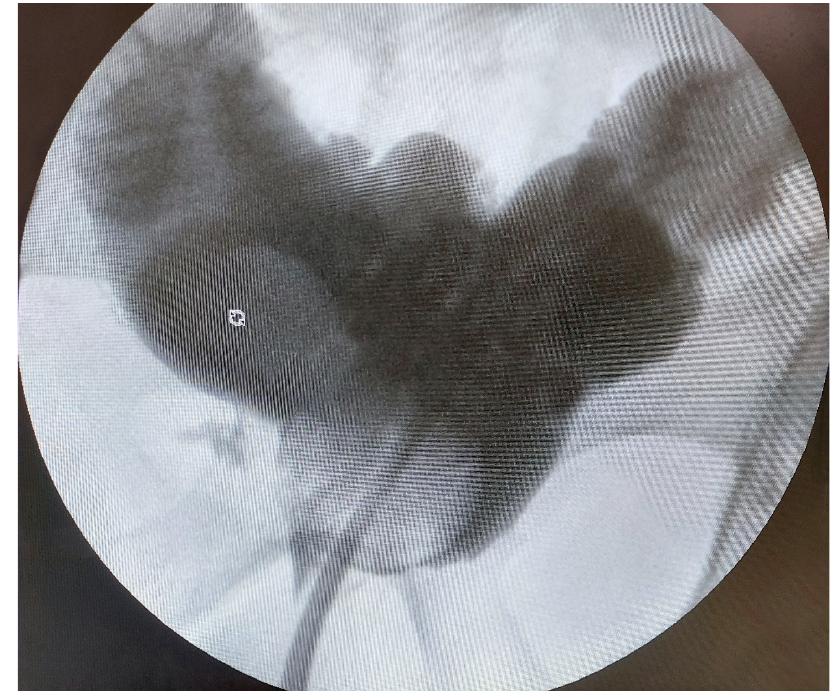
Figure 4. Postoperative cystogram performed before